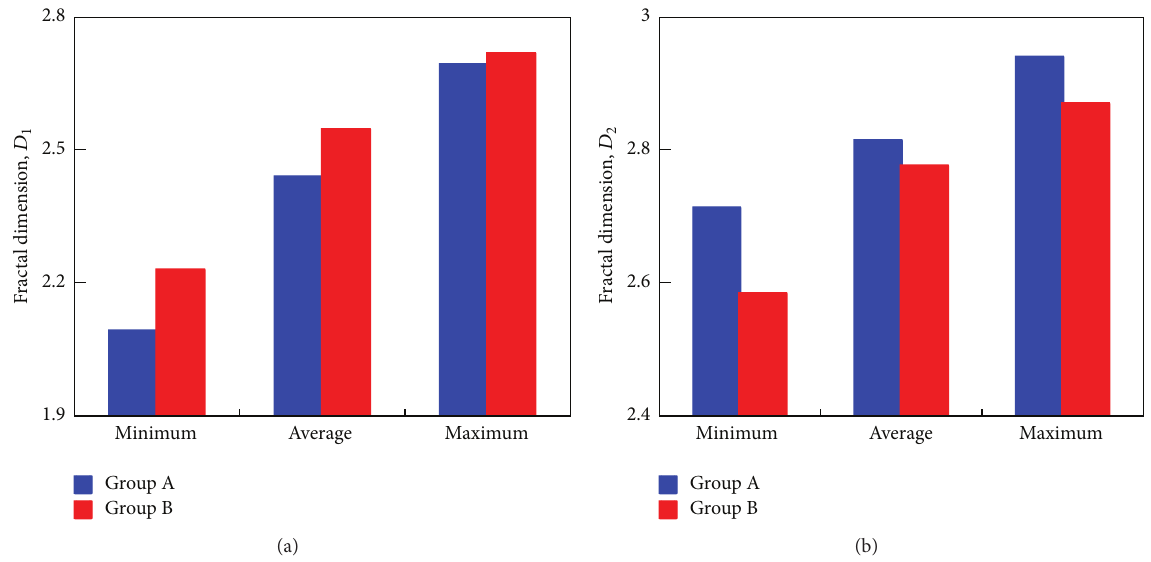
Figure 4: Comparison of fractal dimension 𝐷 1 and fractal dimension 𝐷 2 of shale in groups A and